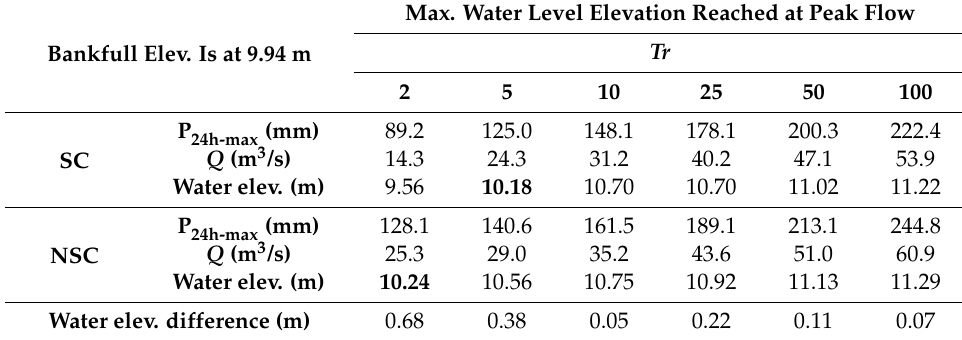
Table 12. Maximum water level (elevations) at cross-section K0+018.5.